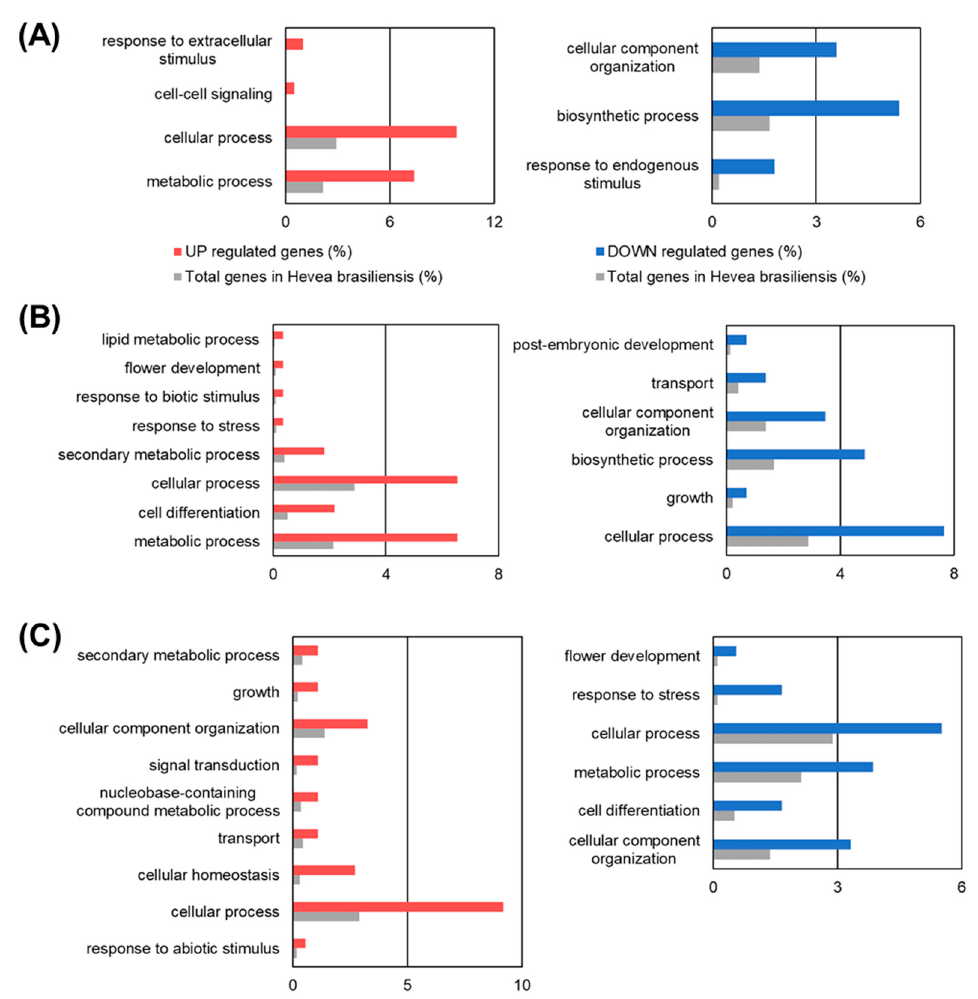
Figure 2. Gene Ontology (GO) enrichment analysis of DEGs. GO enrichment analysis was performed on genes whose expression was upregulated or downregulated upon MeJA treatment for 4 h ( A ), 24 h ( B ), and 5 d ( C ).